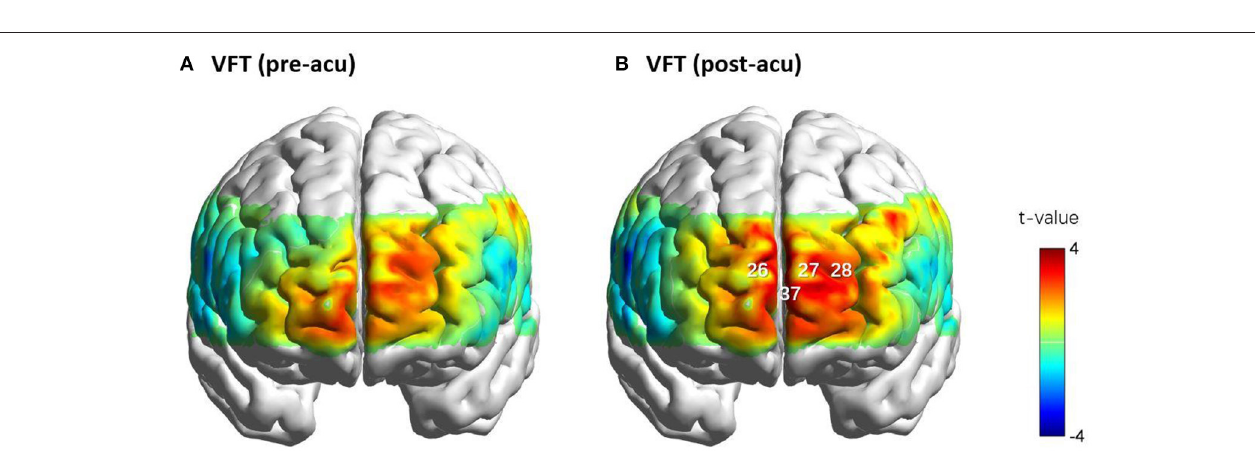
FIGURE 4 | Cortical activation maps of oxy-Hb level during the VFTs before (A) and after acupuncture (B) . Oxy-Hb level changes in CHs 26, 27, 28, and 37 during the VFTs before and after acupuncture. CHs 26, 28, and 37 were located in the frontopolar area, and CH 28 was located in the left dorsolateral pre-frontal cortex. CH, channel; oxy-Hb, oxy-hemoglobin; VFT, verbal fluency task.